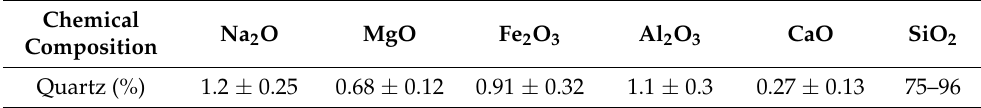
Table 2. Chemical composition of quartz sand.